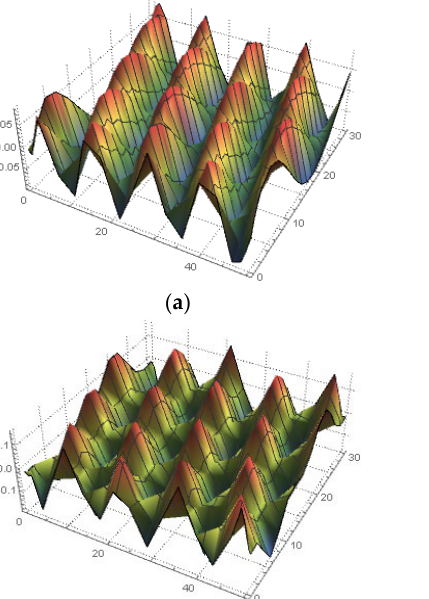
Figure 8. The 3D plots of the real and imaginary parts of F 13 ( x , t ) and G 13 ( x , t ) with the parameters r 1 = r 2 = − 3, k 1 = k 2 = 1, q 0 = 7, p 2 = 2, q 1 = − 5, ρ = 0.5, and τ = 0.1 for the fractional order α = 0.8: ( a ) Re [ F 13 ( x , t )] , ( b ) Re [ G 13 ( x , t )] , ( c ) Im [ F 13 ( x , t )] , ( d ) Im [ G 13 ( x , t )] .